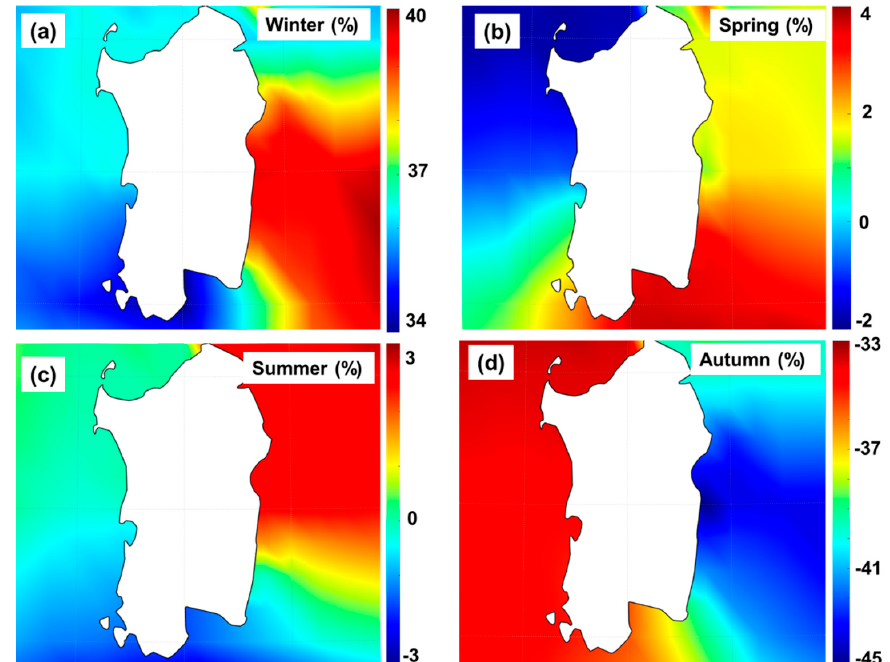
Figure 4. Hs differences (average values in %) between the average values corresponding to the four main seasons and average values corresponding to the total distribution divided by the same average values corresponding to the total distribution, considering the 40-years of ERA-interim data, where: ( a ) winter; ( b ) spring; ( c ) summer; ( d ) autumn.